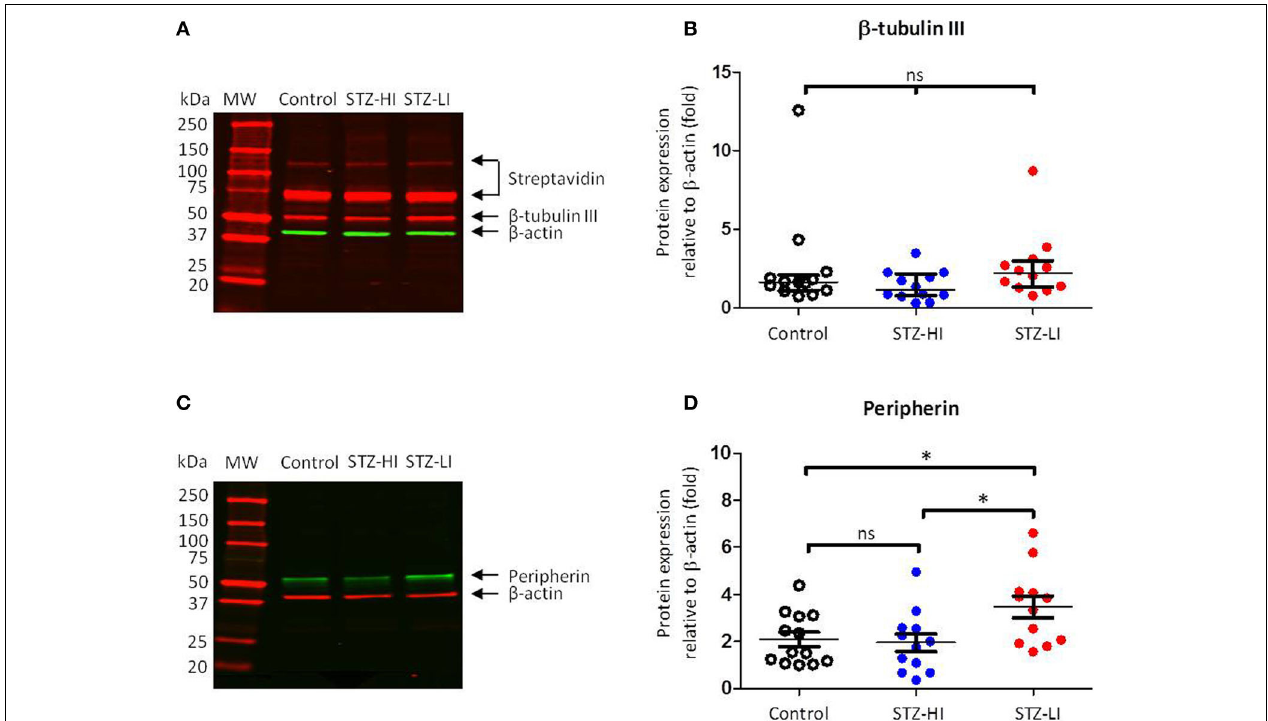
FIGURE 3 | β -tubulin III and peripherin protein levels in plantar metatarsal arteries (PMAs) from control rats ( n = 13) and streptozotocin (STZ)-treated rats that received a low (STZ-LI, n = 12) or a high (STZ-HI, n = 12) dose of insulin. (A,C) Representative Western blots for β -tubulin III (A) and peripherin (C) in PMAs from a control, a STZ-HI and a STZ-LI rat. The predicted molecular weights (MW) for β -tubulin III, peripherin and β -actin were approximately 50, 57, and 45kDa, respectively. (B,D) Protein expression for β -tubulin III (B) and peripherin (D) was measured relative to loading